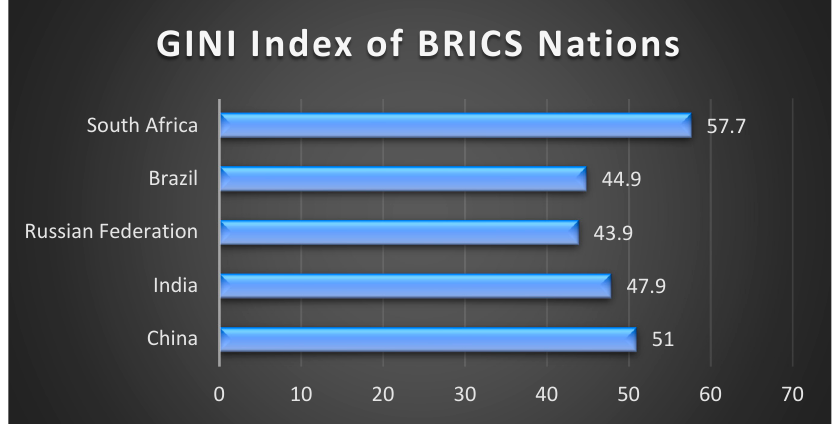
Figure 2. GINI index of BRICS nations. (available online: www.knoema.com, accessed on 10 June 2021)